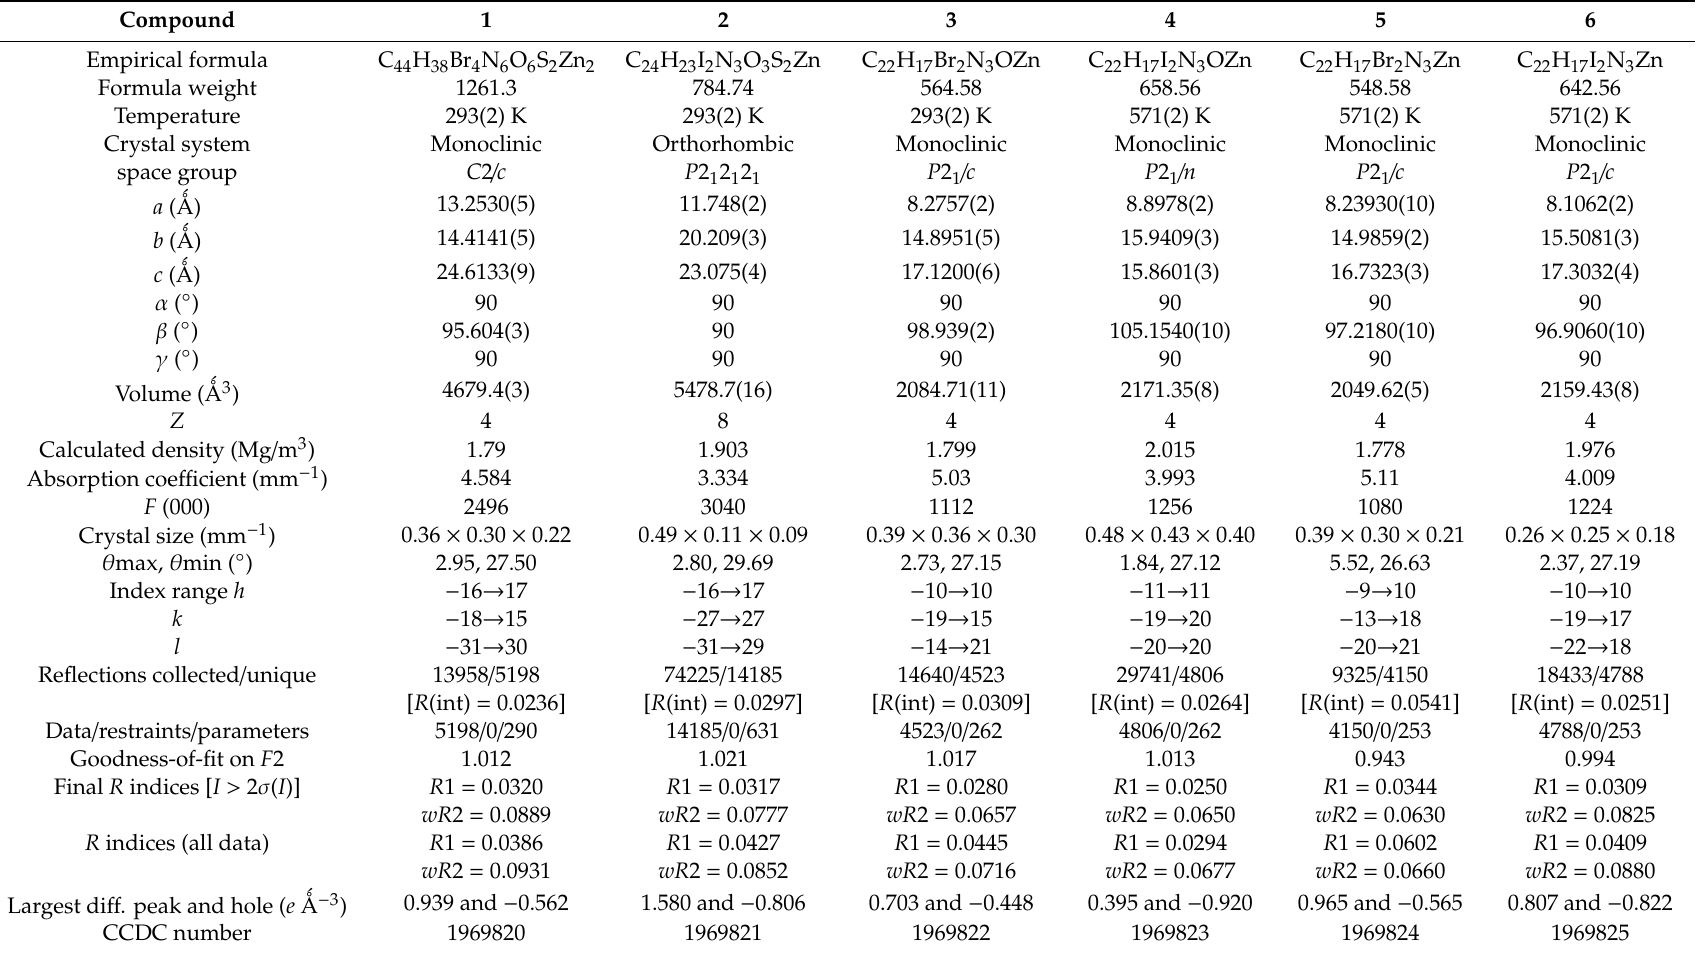
Table 5. Crystal data for compounds 1 – 6